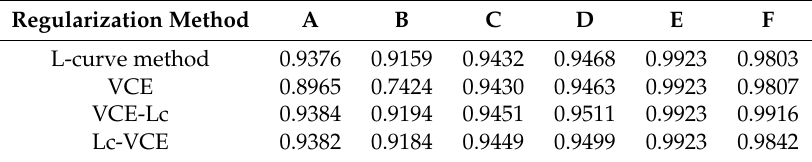
Table 6. Correlations between the estimated coefficients and the validation data of each method for different study